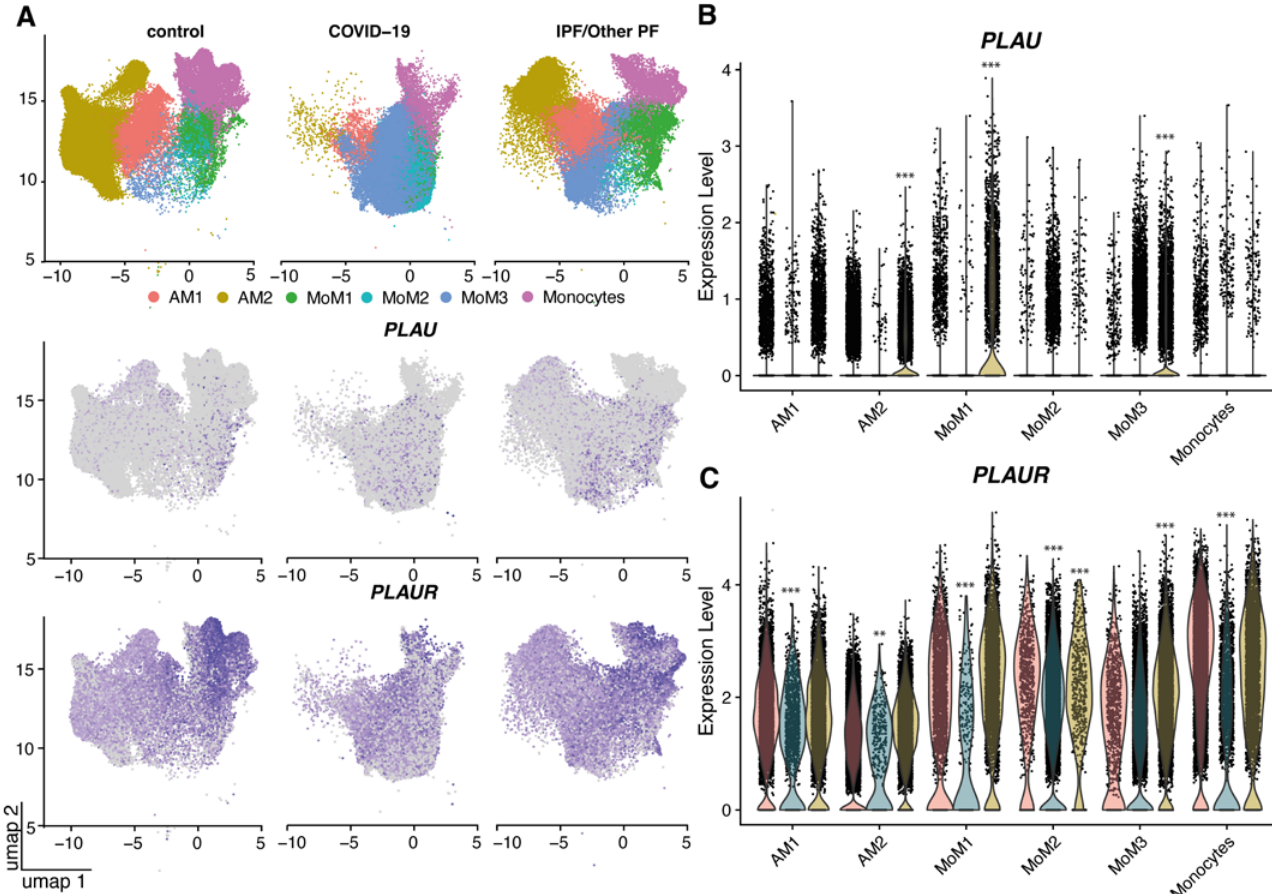
Figure 3. PLAU and PLAUR expression in the immune cells of control, COVID-19 and PF lung samples: ( A ) UMAP embedding of jointly analyzed single-cell transcriptomes annotated by cell type (color) and disease status. Lung tissue transcriptomes of patients with COVID-19-associated pneumonia, pulmonary fibrosis (PF) and control lung samples from healthy donors, reported in Habermann et al. and Bharat et al. (GSE158127, GSE135893 [35,36]), were analyzed. Normalized expression levels of PLAU ( B ) and PLAUR ( C ) in different types of immune cells; statistics were calculated only for cells with the median normalized expression value > 0. ns—non-significant, * p adjusted < 0.01, ** p adjusted < 0.001, *** p adjusted < 0.0001 as assessed by FDR. AM, alveolar macrophages; IPF/other PF, idiopathic pulmonary fibrosis and other pulmonary fibrosis; Mo, monocyte-derived macrophages; umap, Uniform Manifold Approximation and